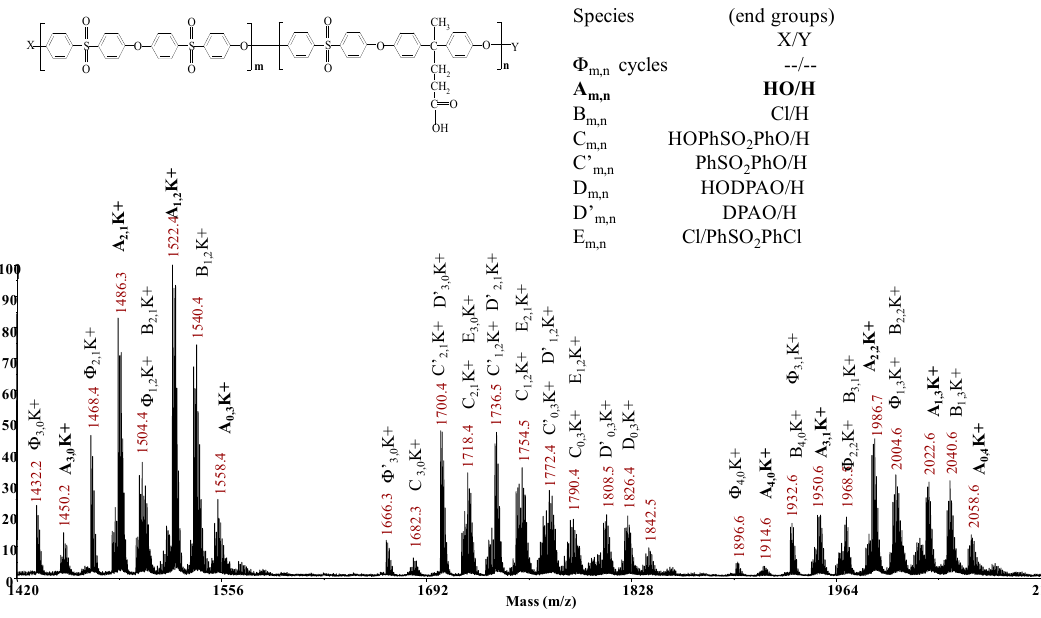
Figure 5. Enlarged section of the MALDI-TOF mass spectrum of the P(ESES-co-ESDPA) 50:50 copolymer.